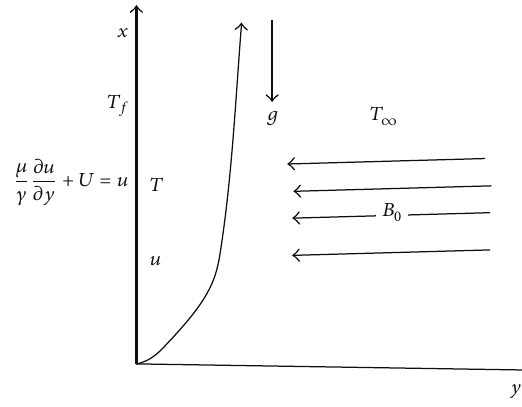
Figure 1: Flow configuration and coordinate